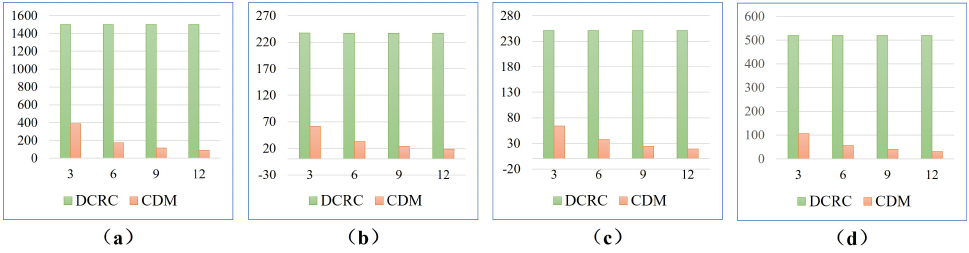
Figure 17. The comparison of computation times for four different environments. Less computation times are better. ( a – d ) show comparison results in multi-cell, farm, rual quebec, and cave scenes,